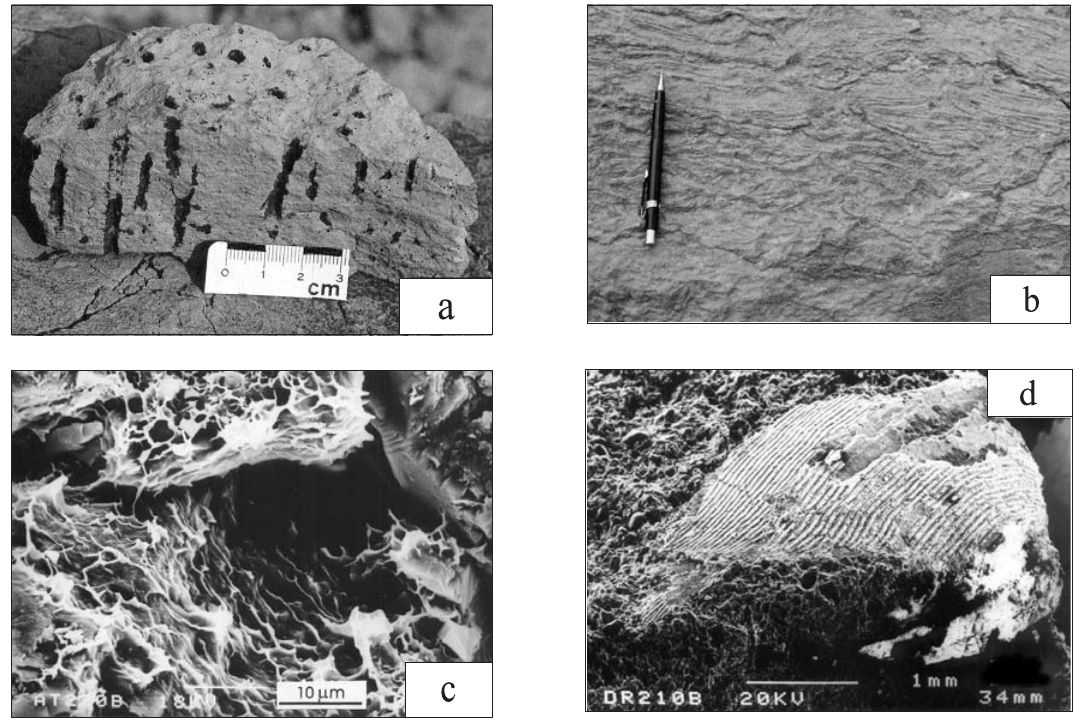
Fig. 4 (photos) – a) Root casts 3D view, Araçatuba Formation. Location: SP 304 highway, close to km 412, SE of Novo Horizonte (UTM: 686993/7619892). b) Dish structures. Outcrop situated on theAraçatuba and Vale do Rio do Peixe formations transition zone. (SP), Location: SP 321 highway, around km 472, Itajobi (UTM: 702382/7641240). c) Pore linning corrensite, Araçatuba Formation. SEM Image. Location: SP 425 highway, km 348.7; close to entrance to Piacatu (UTM: 542015/7602721). d) Bioclast (conchostraca?) in massive siltstone, Araçatuba Formation. SEM image. Location: Alfredo Marcondes-SP 294 road, km 72.2, north of Flora Rica (UTM: